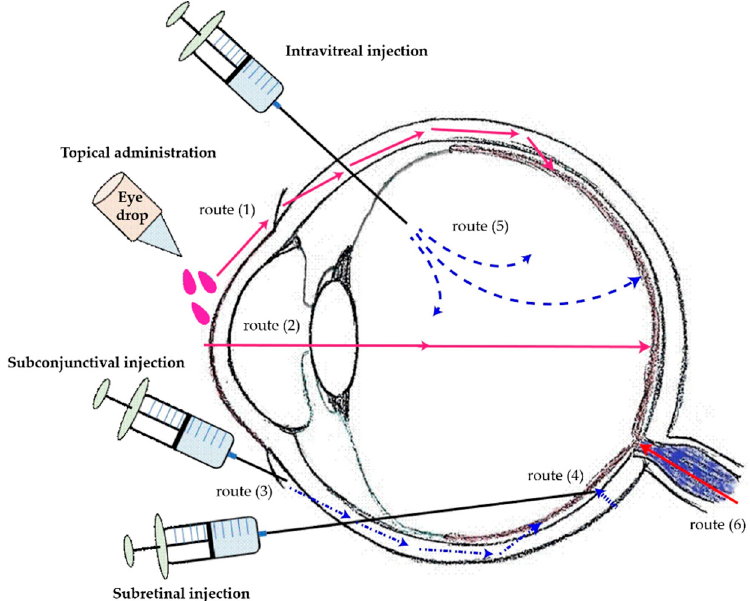
Figure 2. Methods of ocular drug administration and its delivery routes to the posterior segment. Routs of drug transportation to the back of the eye via topical administration (1 and 2), subconjunctival injection (3), subretinal injection (4), and intravitreal injection (5). The drug transportation from the systemic circulation via oral medication (6).